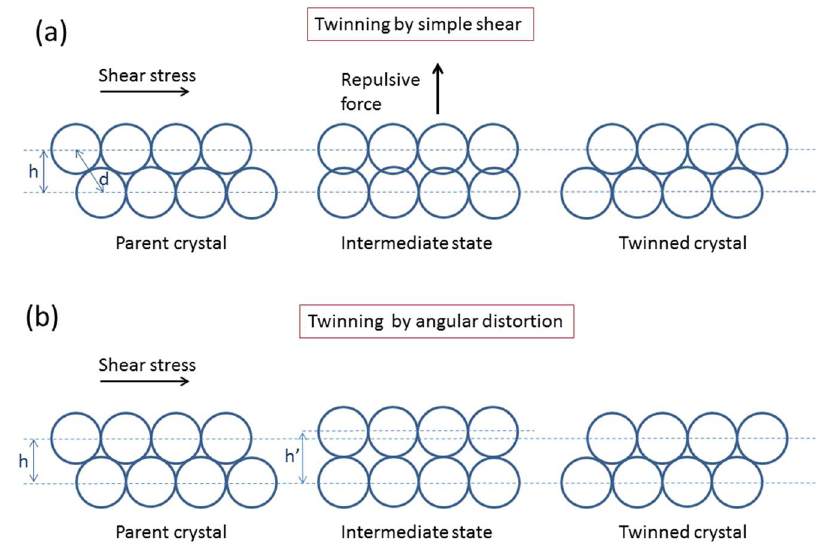
Figure 9. Schematic two-dimensional (2D) representation of a collective displacement of atoms during deformation twinning, according to ( a ) simple shear (with internal friction) or ( b ) angular distortion (in a free crystal).